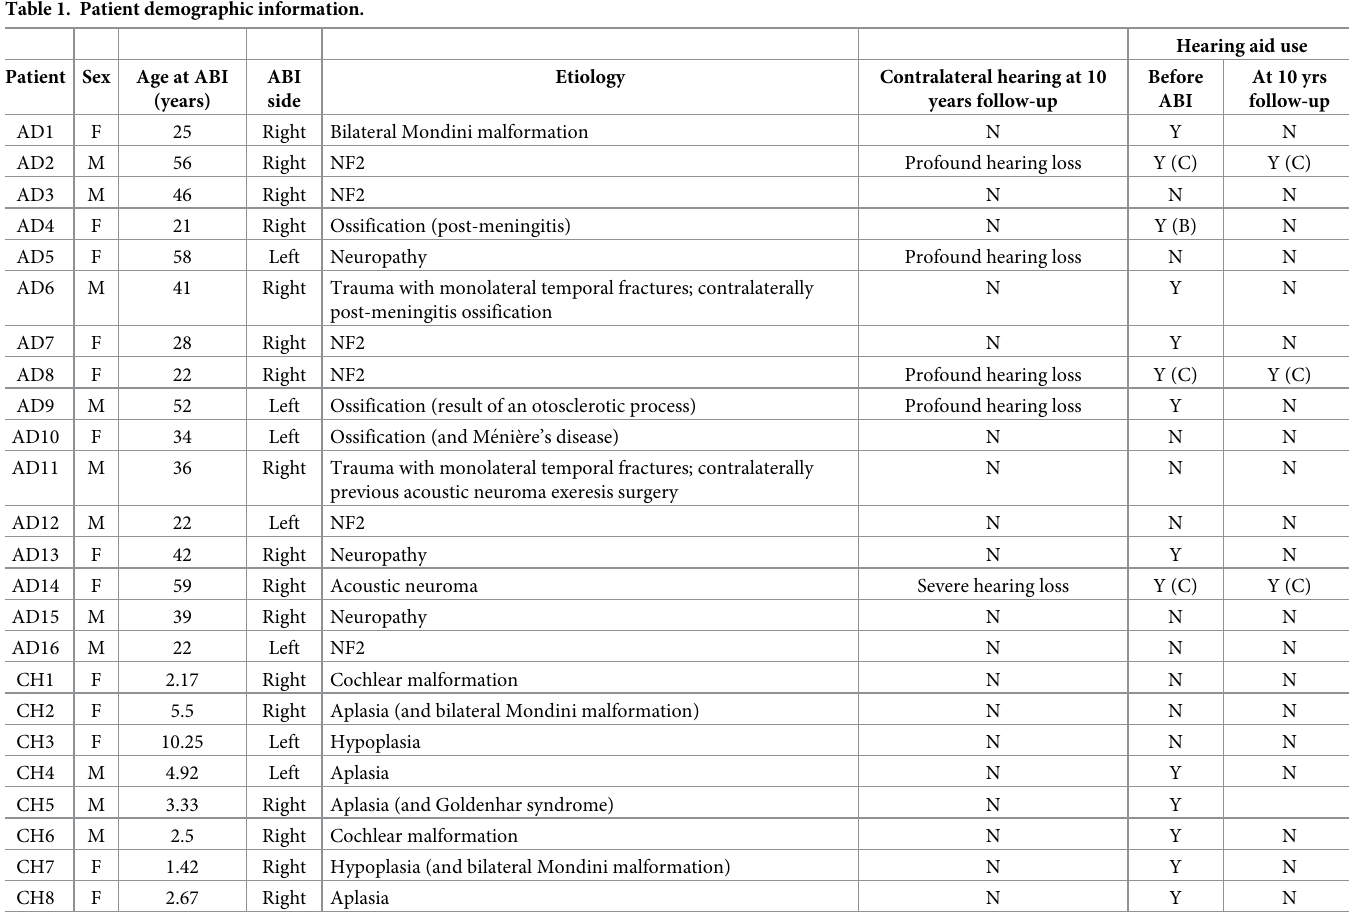
Table 1. Patient demographic